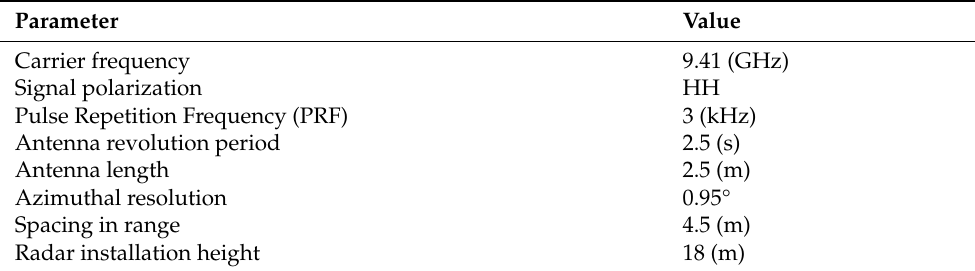
Figure 4. WaMoSII radar image acquired in Haifa bay, showing the main and lee breakwaters and location of the WaMoSII wave analysis areas at 2 km off the radar. Table 1. Radar characteristics (signal, acquisition,